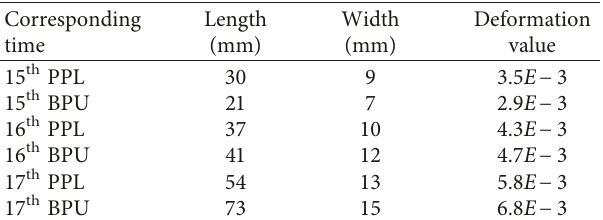
Table 1: Characteristic parameters of localization band at each corresponding